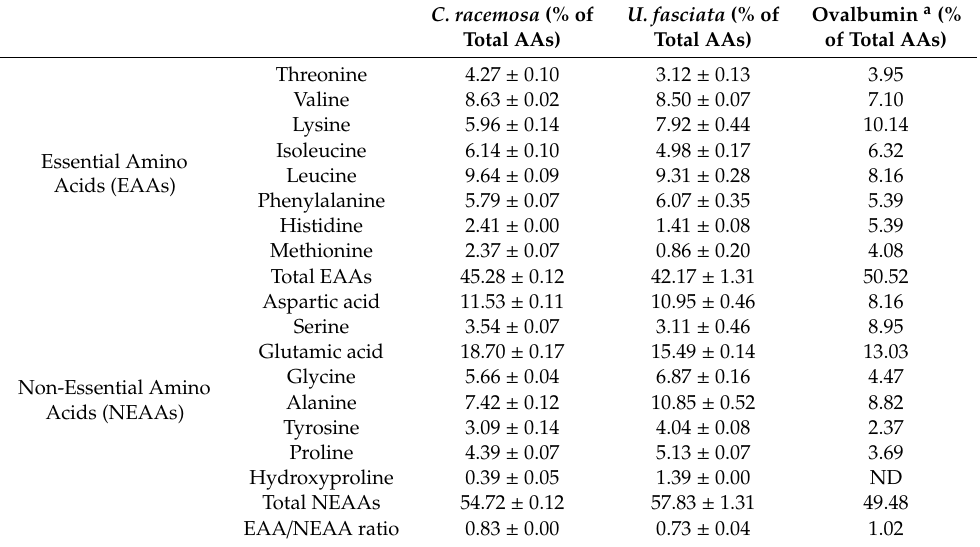
Table 5. Amino acid compositions of Caulerpa racemosa and Ulva fasciata expressed as a percentage (%) of the total amino acids detected by gas chromatography.